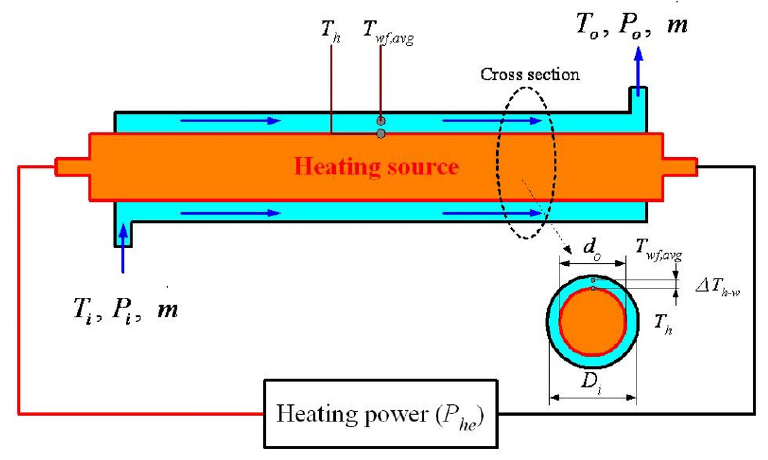
Figure 1. A schematic diagram of the THE.